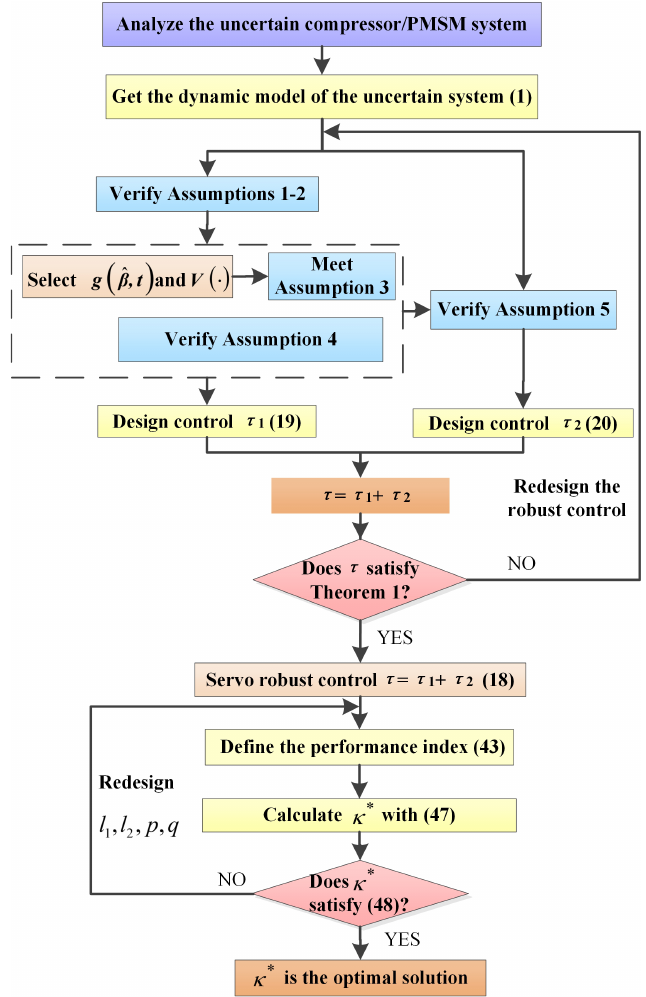
Figure 3. Design